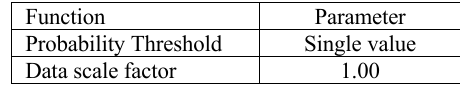
Table 2. Description of the parameters with the Maximum Likelihood (ML)